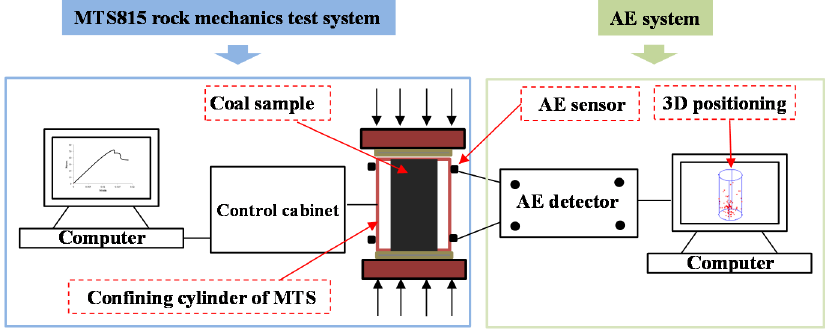
Figure 2. Schematic diagram of MTS815 rock mechanics test system and acoustic emission (AE) system.